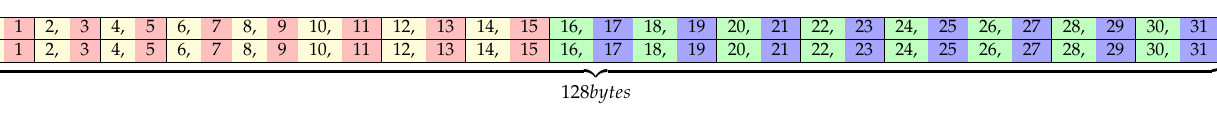
Figure 12. Final data reading order from shared memory to registers after the shuffle of elements.